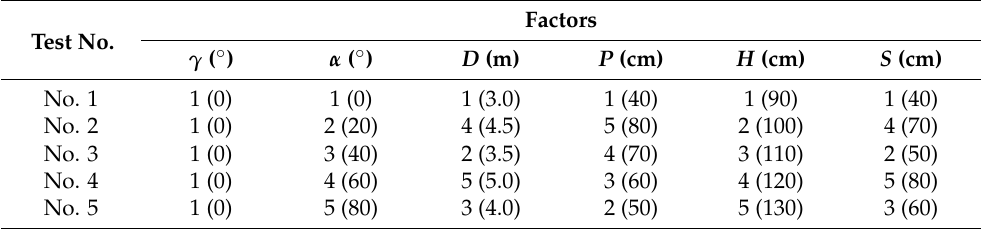
Table 8. Orthogonal numerical test design table of massive integrity structure rock